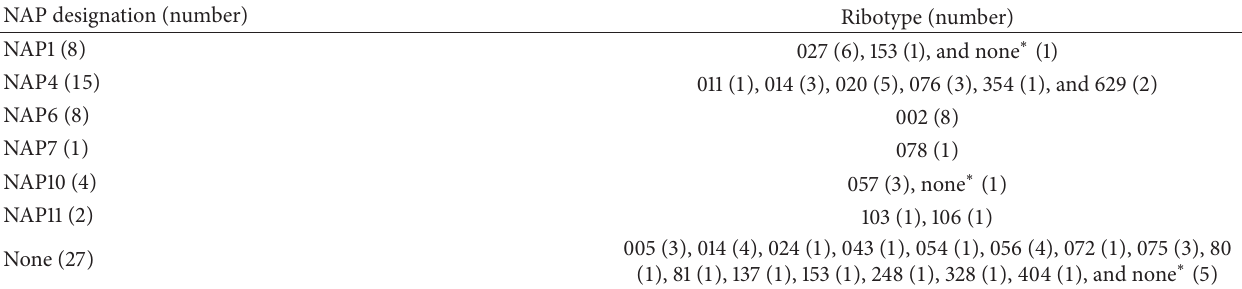
Table 4: PCR-ribotypes of C. difficile ( 𝑛 = 68 ) from LabA in 2013 by NAP